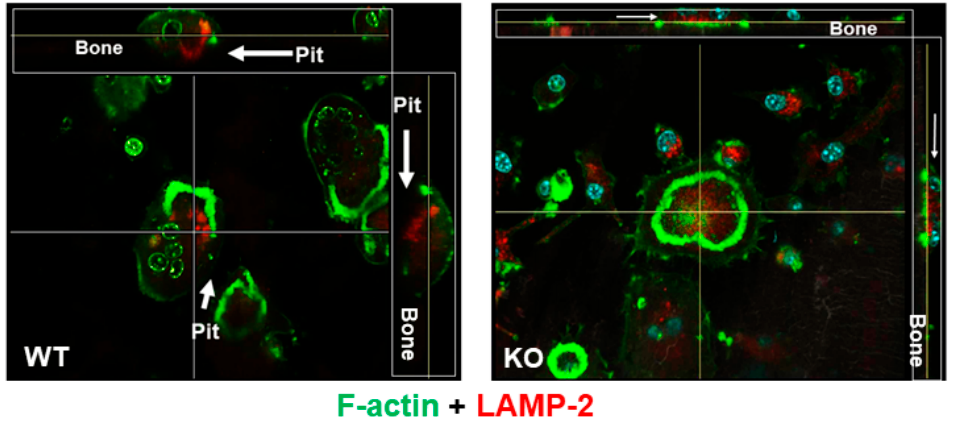
Figure 2. Lack of LRRK1 in osteoclasts impairs lysosome distribution to the ruffled border. Differentiated osteoclasts on bone slices were probed with monoclonal anti-lysosomal associated membrane protein 2 (LAMP-2) antibody from rat, followed by staining with rhodamine-conjugated anti-rat IgG second antibody. F-actin of the osteoclasts was stained with Alexa fluor-488-conjugated phalloidin. Immunofluorescent staining was analyzed on a confocal microscope. The two lines in the middle of the cell represent the positions of horizontal and vertical cuts, respectively. Arrows indicate F-actin and LAMP-2 associated lysosomes with a dent on the horizontal and vertical cross-sections of WT and LRRK1-deficient osteoclasts, respectively.